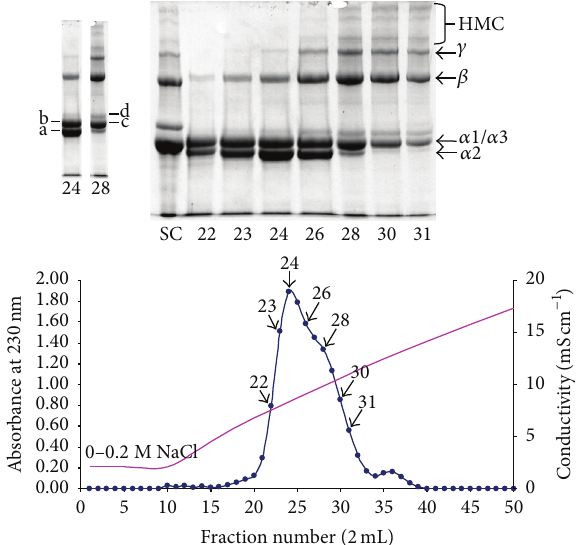
Figure 2: Elution profile of collagen from the skin of splendid squid (SC) on the TOYOPEARL CM-650M ion-exchange column. The fractions indicated by numbers were examined by SDS-PAGE using 5% separating gel and 4% stacking gel. HMC denotes high-MW cross-linked component.